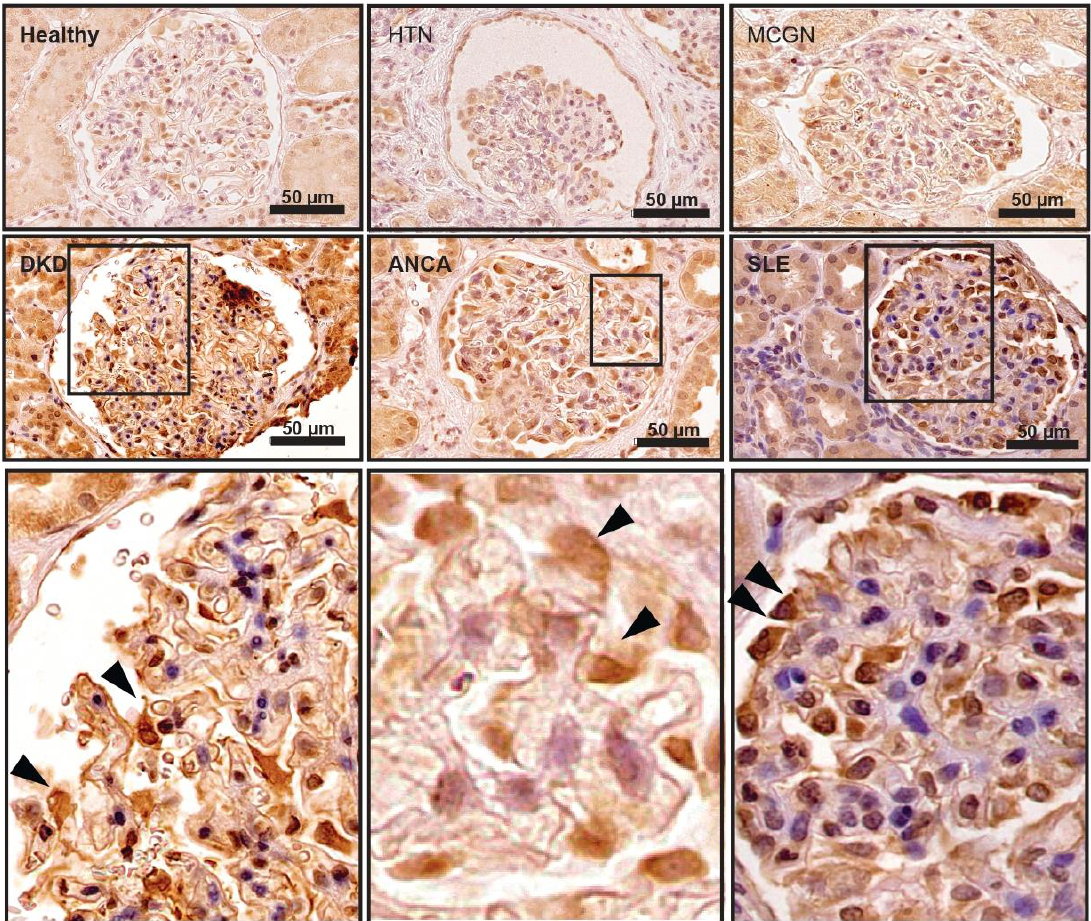
Figure 1. PON2 expression is induced in diabetic and inflammatory human glomerular kidney disease. Human kidney biopsy samples stained with PON2 specific antibody. PON2 reactivity is primarily localized in tubular cells in healthy kidney as well as in hypertensive (HTN) and minimal change (MCGN) glomerular disease while glomeruli show faint staining. PON2 staining is pronounced in glomeruli in diabetic kidney disease (DKD), ANCA vasculitis (ANCA), and lupus nephritis (SLE). Specifically, PON2 expression is predominant in podocytes (arrow heads) localizing to the outer aspect of the glomerular tuft.